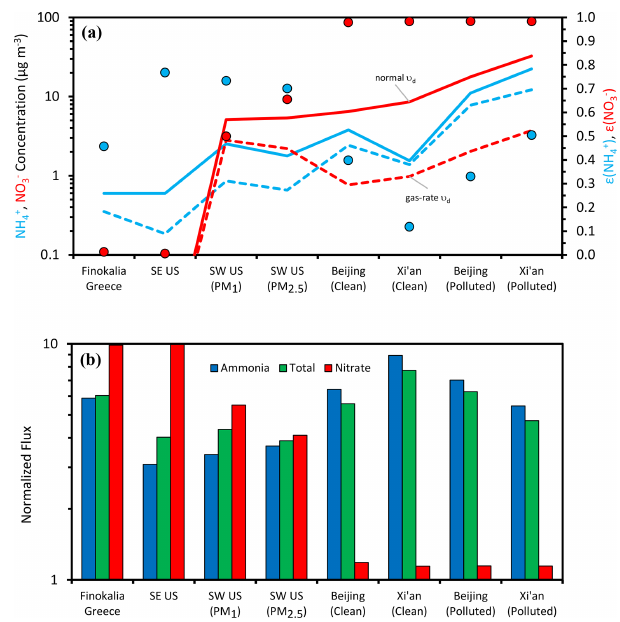
Figure 4. Acidity and aerosol water impacts on aerosol concentra- tion and deposition flux in select regions of the world that represent strongly acidic conditions (SE United States), intermediate acidity conditions (SW United States, Greece), and mildly acidic condi- tions (China). Shown is (a) the concentration of aerosol ammonium and nitrate and the impact of deposition velocity determined by the aerosol acidity state and (b) the impact of acidity state on normal- ized ammonia, nitrate, and total reduced nitrogen flux.